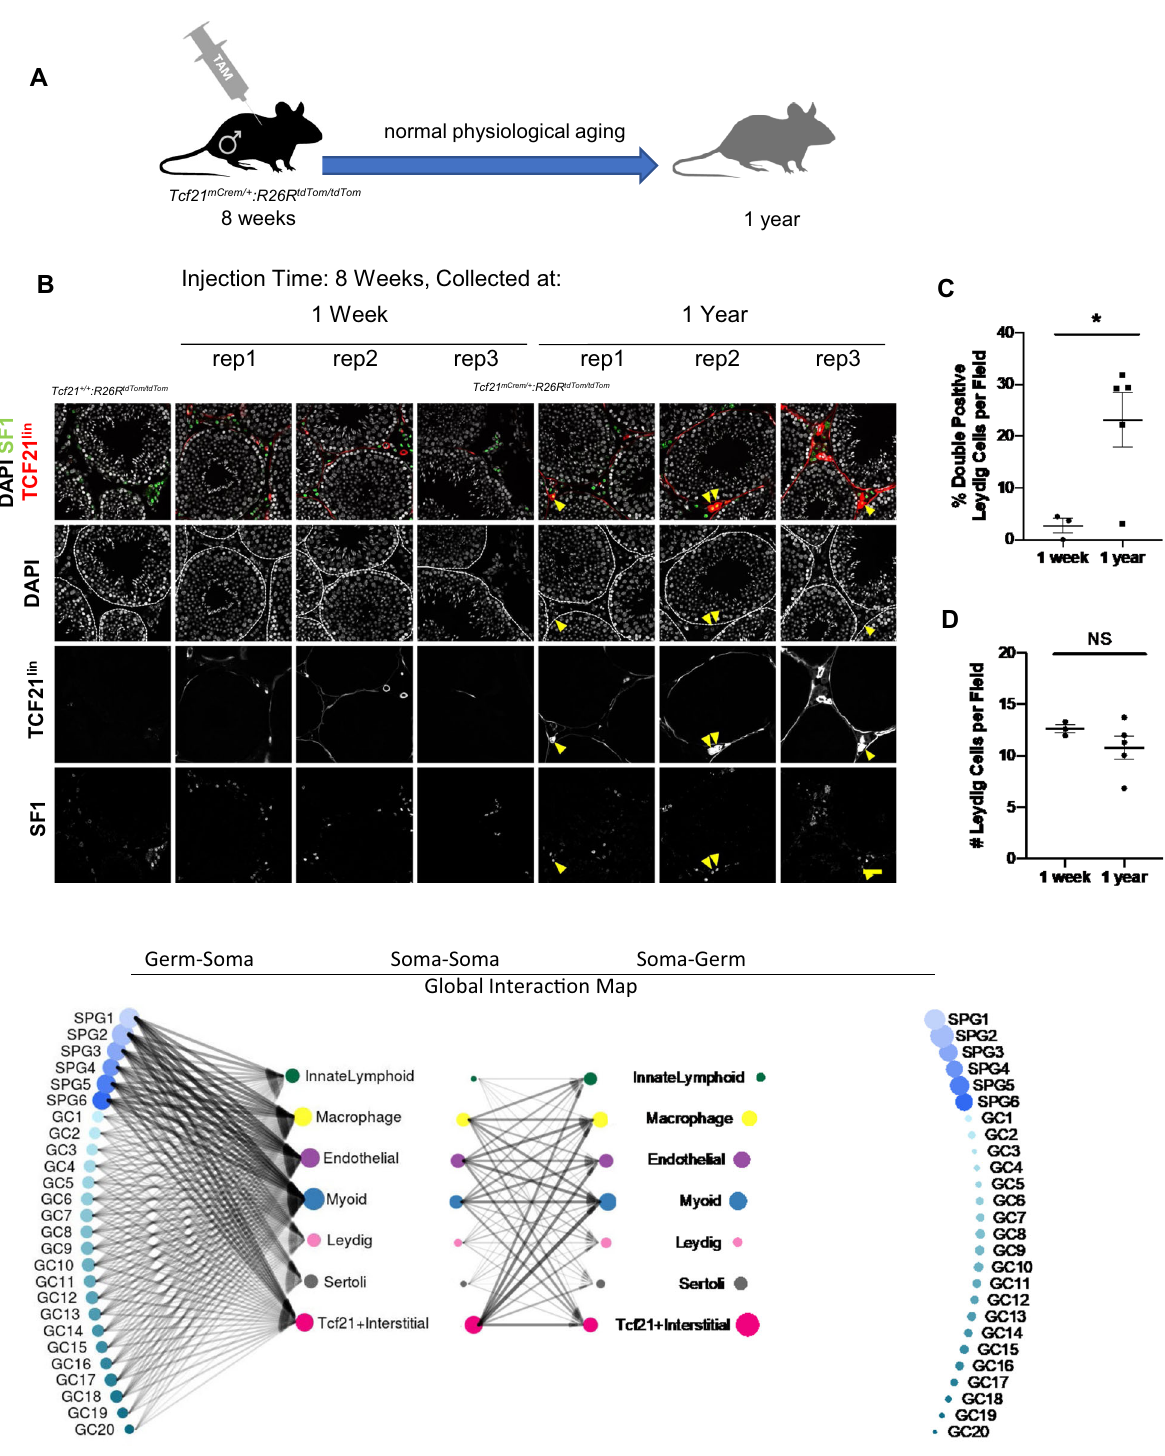
Fig. 6 The TCF21 lin population maintains testis tissue homeostasis during aging. A Schematic representation of TCF21 lineage tracing in the aging testis. B Colocalization of TCF21 lin (tdTom) and Leydig cell marker SF1 (green) at 1 week or 1 year following a single injection of tamoxifen in 8-week-old adults. Scale bar: 20 μ m all panels. DAPI is used as the nuclear counterstain (white). (Oil only control n = 2, demonstrating the tight control of TCF21-Cre, n = 3 for 1 week, n = 5 for 1 year). C Quanti fi cation of the percent of Leydig cells expressing both SF1 and TCF21 lin (tdTom) per fi eld (Note — each circle/square represents the percentage per animal; n = 3 for 1 week, n = 5 for 1 year). P = 0.016. Data are presented as mean ± SEM. All statistical tests were performed using Welch ’ s unpaired, two-sided t -tests. D Quanti fi cation of Leydig cell number per fi eld (Note — each circle/square represents the percentage per animal; n = 3 for 1 week, n = 5 for 1 year). P = 0.19. Data are presented as mean ± SEM. All statistical tests were performed using Welch ’ s unpaired, two- sided t -tests. E Summary of putative ligand – receptor interactions in the mouse testis between the germline and soma (left), within soma (center), and soma and germline (right). Arrows summarize top 5% of all interactions. ScRNA-seq data from 42 , processed as described in 34 . Symbol size indicates the number of receptor – ligand interactions contributed by a cell type and line width shows the number of interactions between the two cell